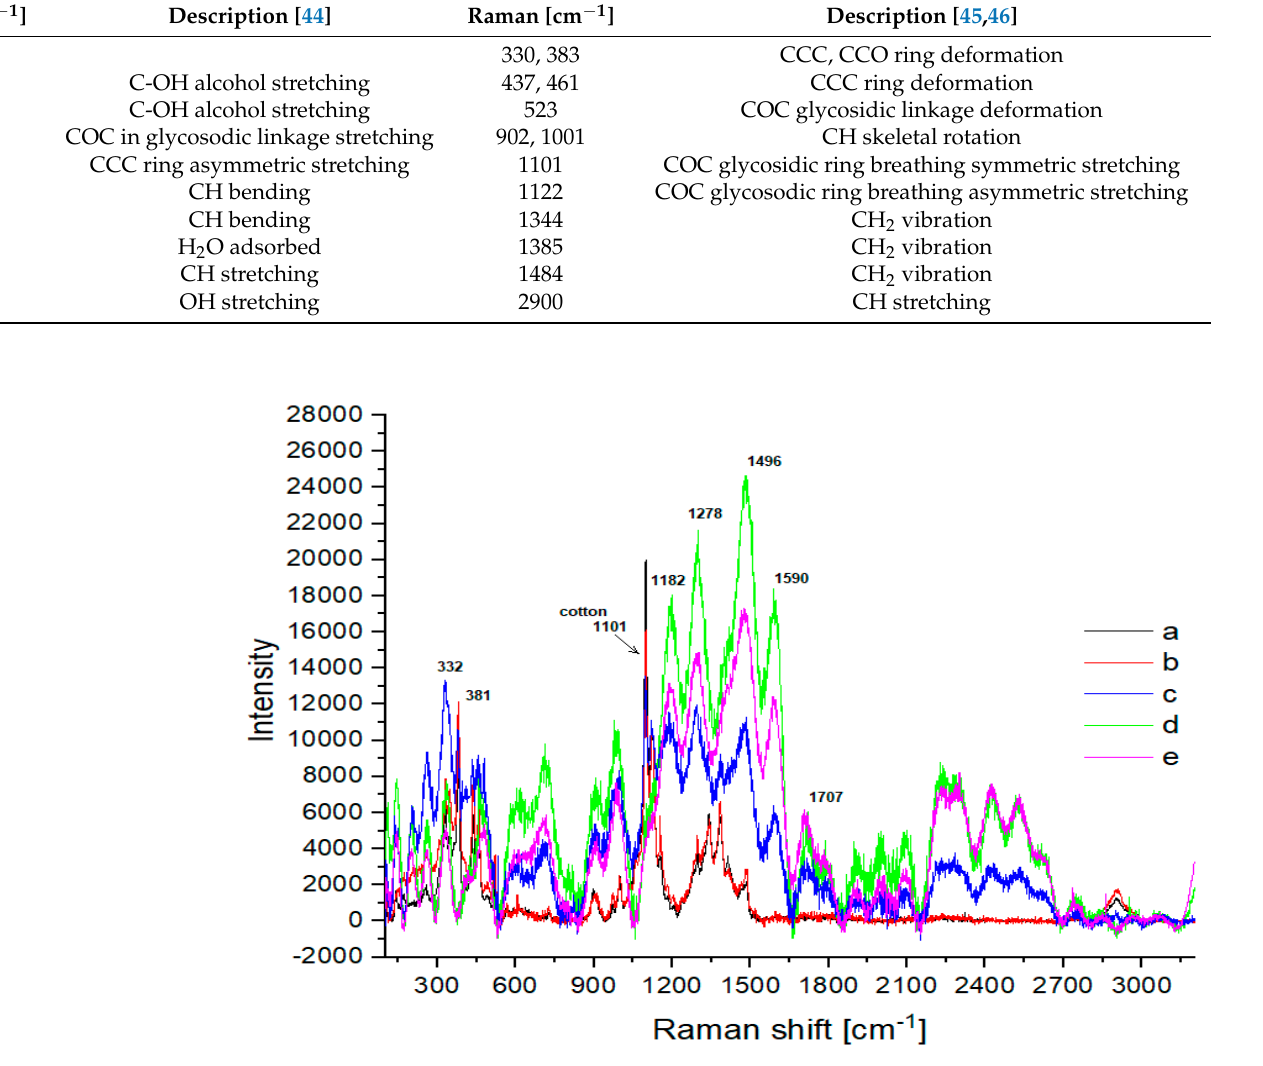
Figure 5. Raman spectra of ( a ) washed cotton and cotton treated for 2 h with 2% H 2 SO 4 at various temperatures: ( b ) 120 °C; ( c ) 140 °C; ( d ) 160 °C; ( e ) 200 °C.